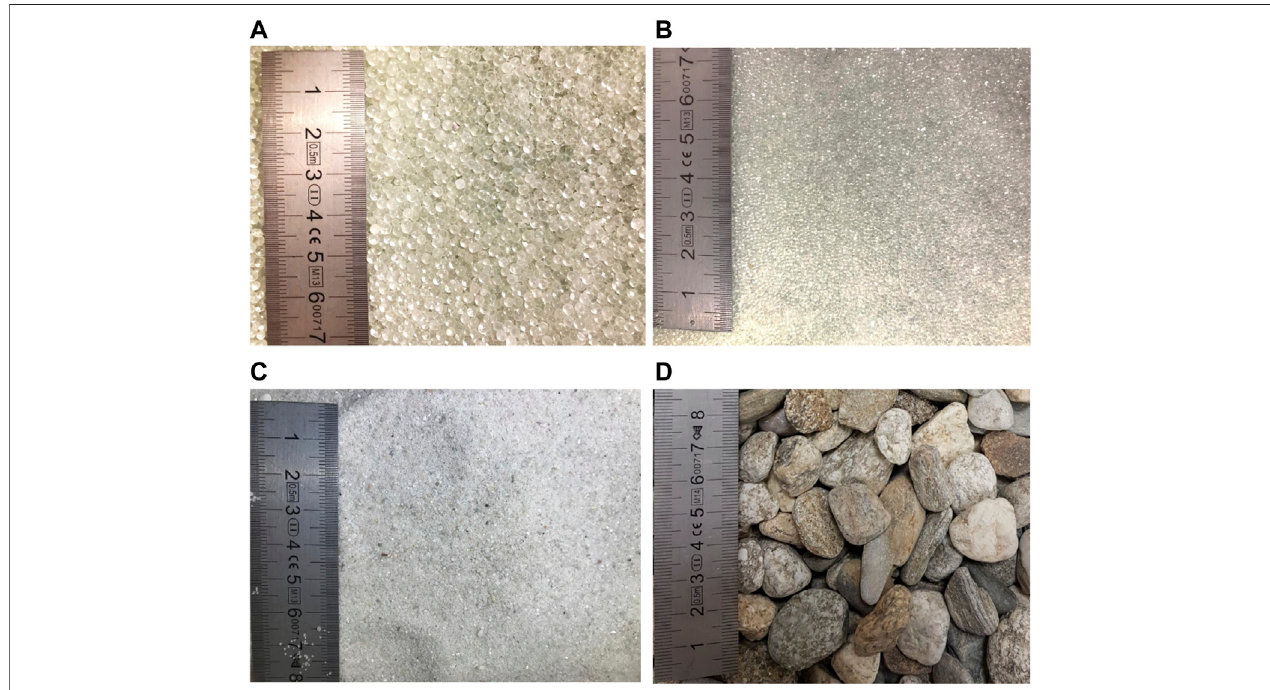
FIGURE 3 | The porous medium materials for the column tests: (A) large silica balls; (B) small silica balls; (C) sand; (D) coarse gravel.